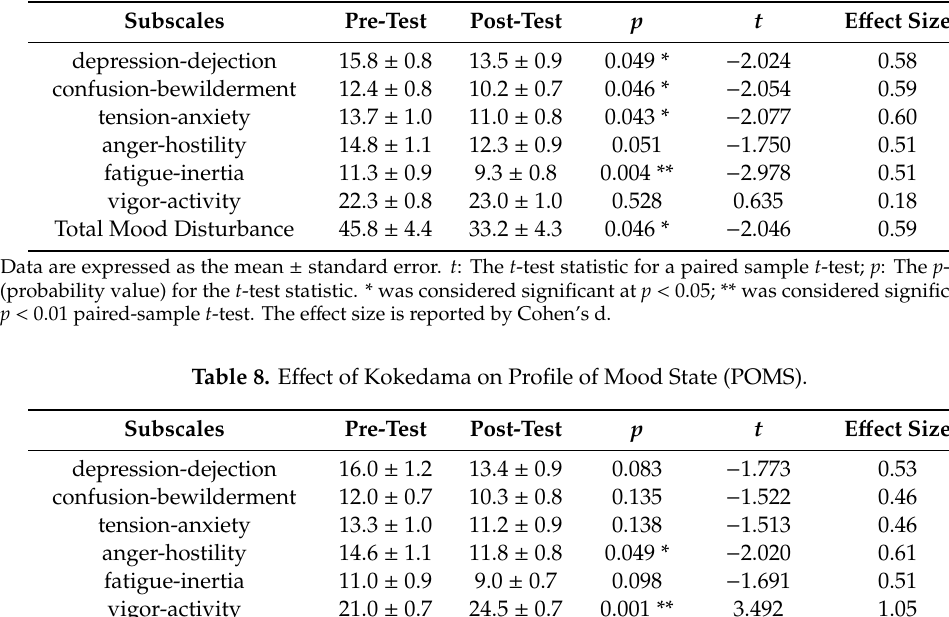
Table 7. E ff ect of Grass Doll on Profile of Mood State (POMS).